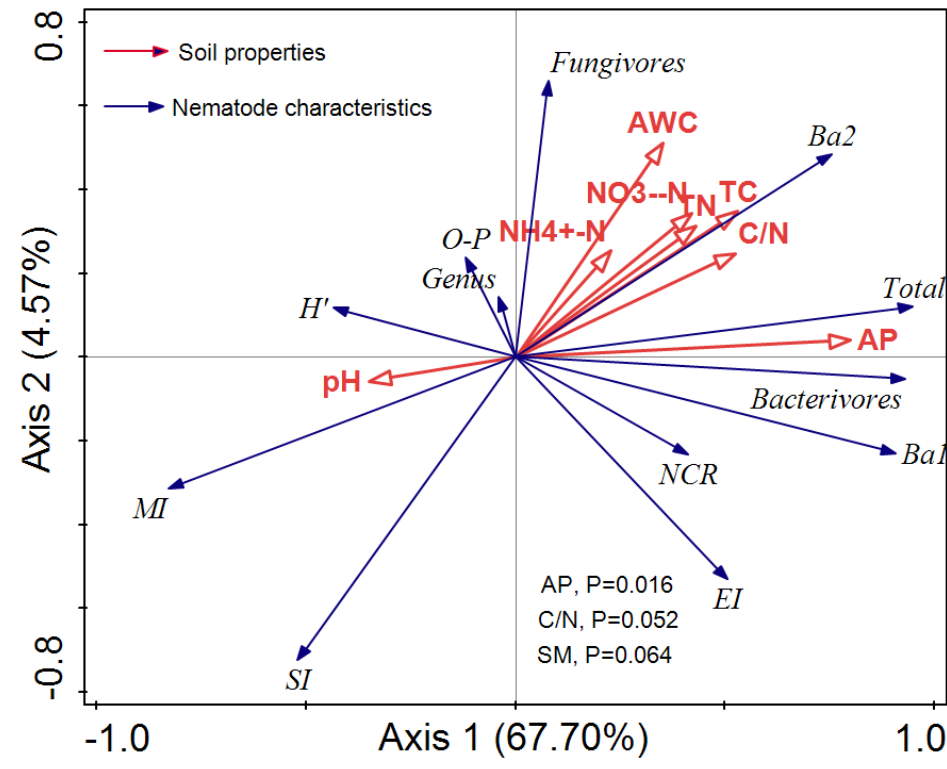
Figure 5. Redundancy analysis of the relationships between soil properties and the abundances of nematodes at the trophic group level and functional guild level. Blue line vectors represent nematode abundances and community characteristics; red line vectors represent soil chemical properties. The length of the line vectors represents the degree of correlation between an environmental factor and soil nematodes. The longer the connection, the greater the correlation, and vice versa. The smaller the angle, the higher the correlation; otherwise, the lower the correlation. O-P, the sum of omnivores and predators; Ba x represents the functional guilds that reflect the nematode trophic group of bacterivores; x is the c-p value. SM, soil moisture; SOC, soil organic carbon; TN, soil total nitrogen; NH 4+ -N, nitrogen from ammonium; NO 3 − -N, nitrogen from nitrate; AP, available phosphorus; n =